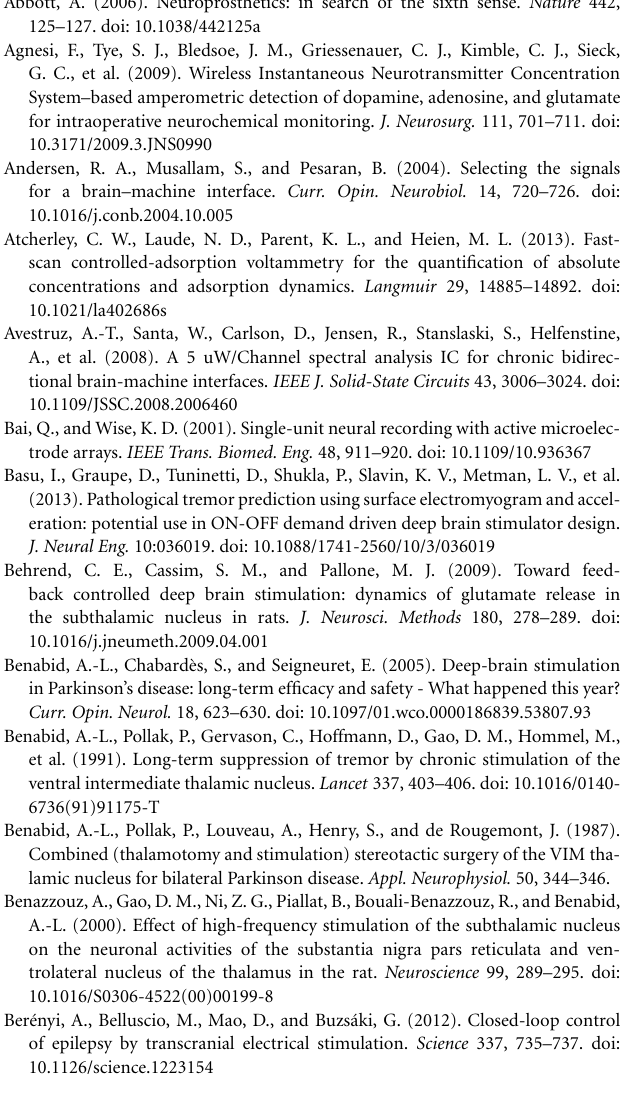
controller. Two typical responses are shown. (B) Target and actual responses were compared using linear regression and Pearson’s correlation ( R 2 = 0 .